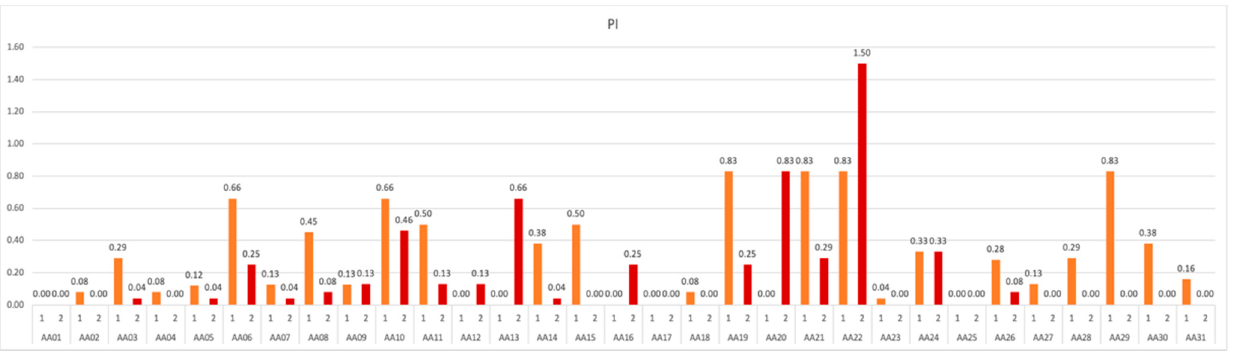
Figure 9. PI values obtained in subsequent measurements over the course of study.